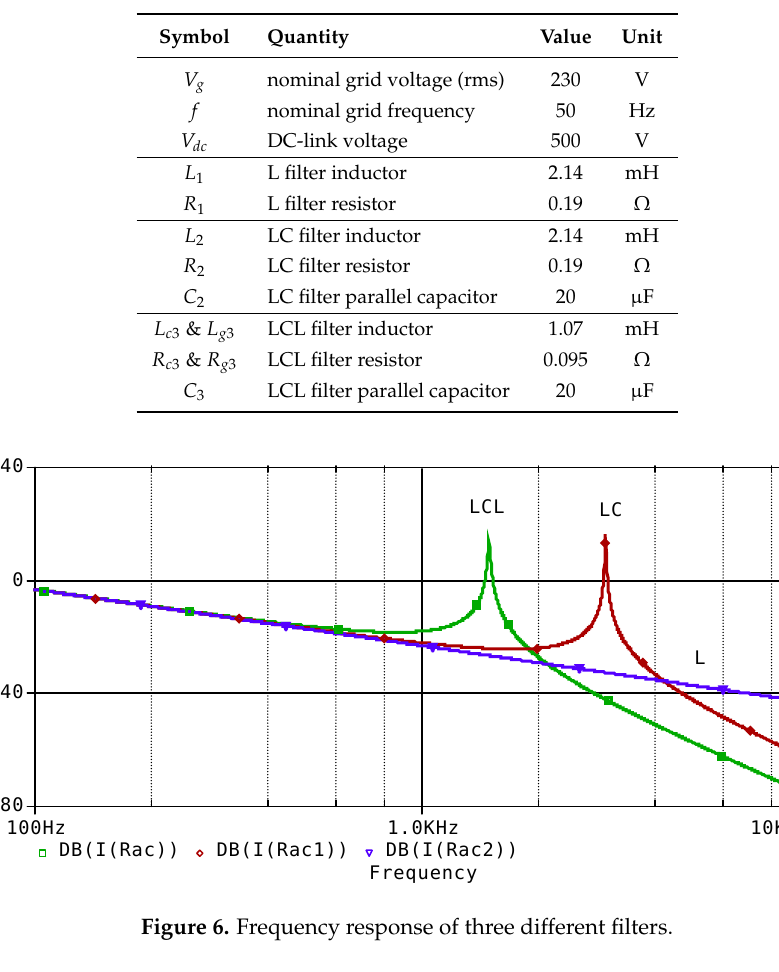
Table 1. Single-phase GCC system parameters.